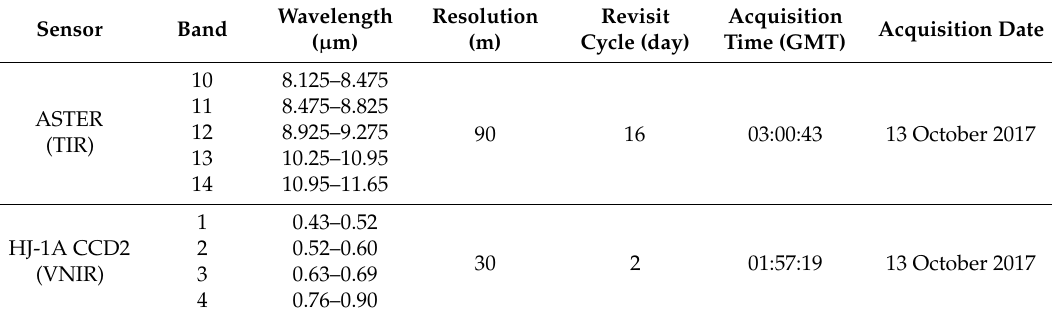
Table 1. Technical specifications of ASTER TIR and HJ-1A CCD2 VNIR